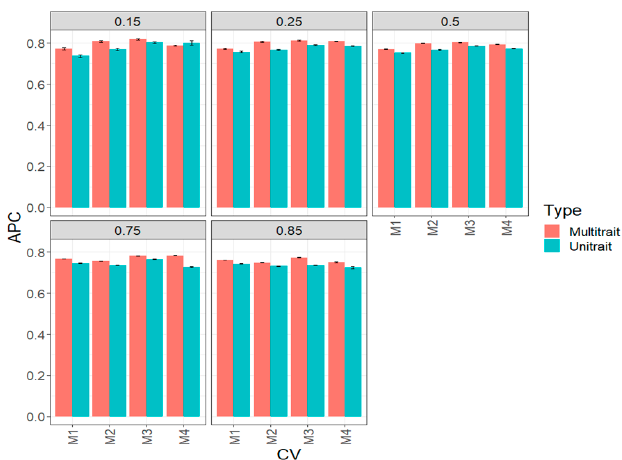
Figure 6. Prediction performance across data sets in terms of average Pearson’s correlation (APC) of the four methods of sparse testing (M1, M2, M3 and M4) under unit-trait and multi-trait models for 5 percentages of testing: 15% (0.1), 25% (0.25), 50% (0.5), 75% (0.75) and 85% (0.85).